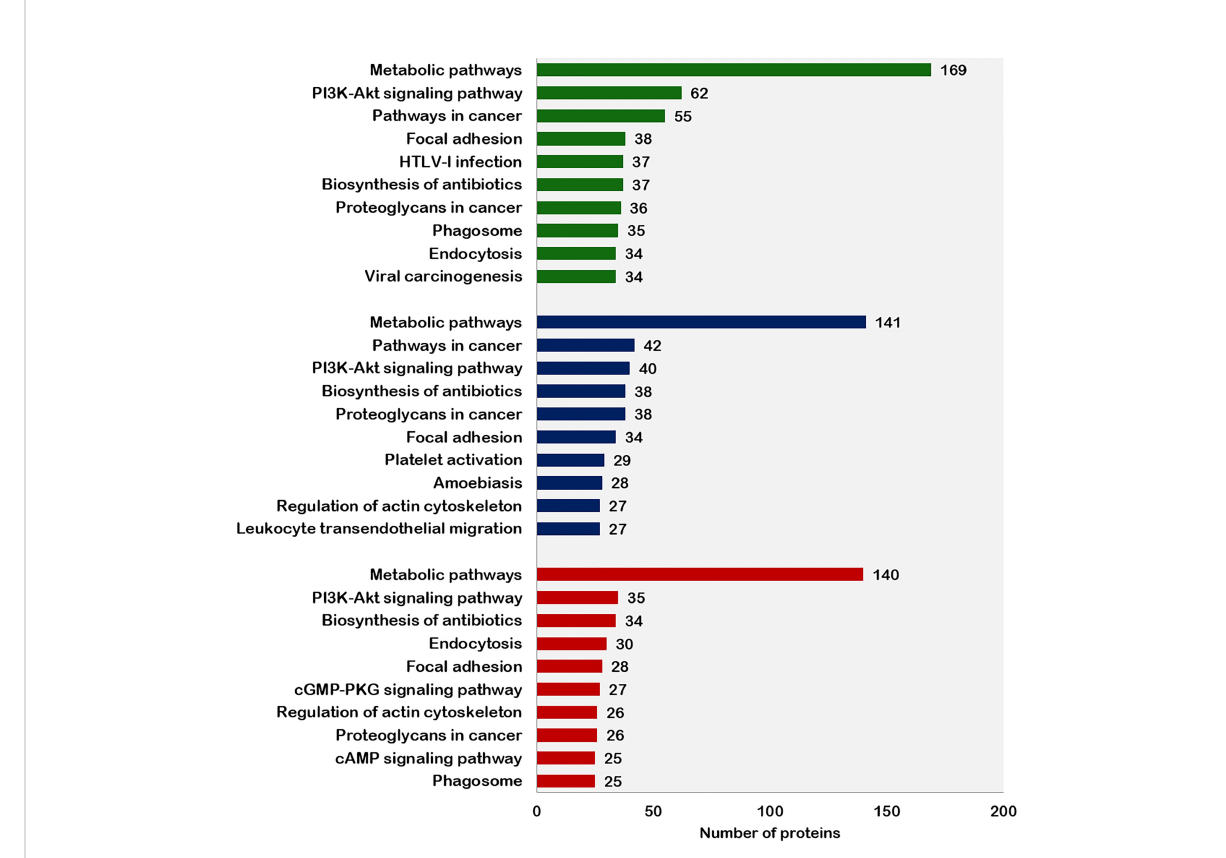
FIGURE 4 Top 10 pathways enriched with proteins from fresh, equilibrated, and cryopreserved